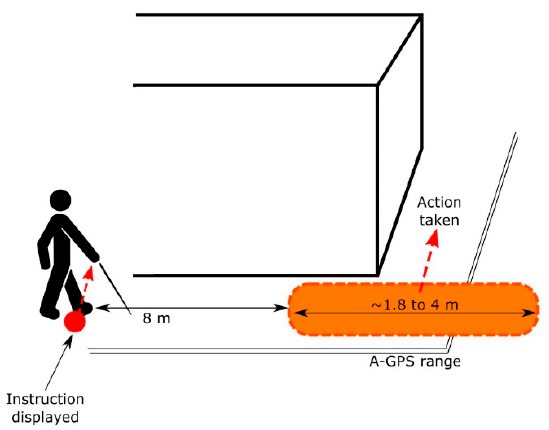
Figure 8. Instruction display strategy: instructions are displayed in advance reducing the possibility of conveying them down the sidewalks or when crossing the streets.